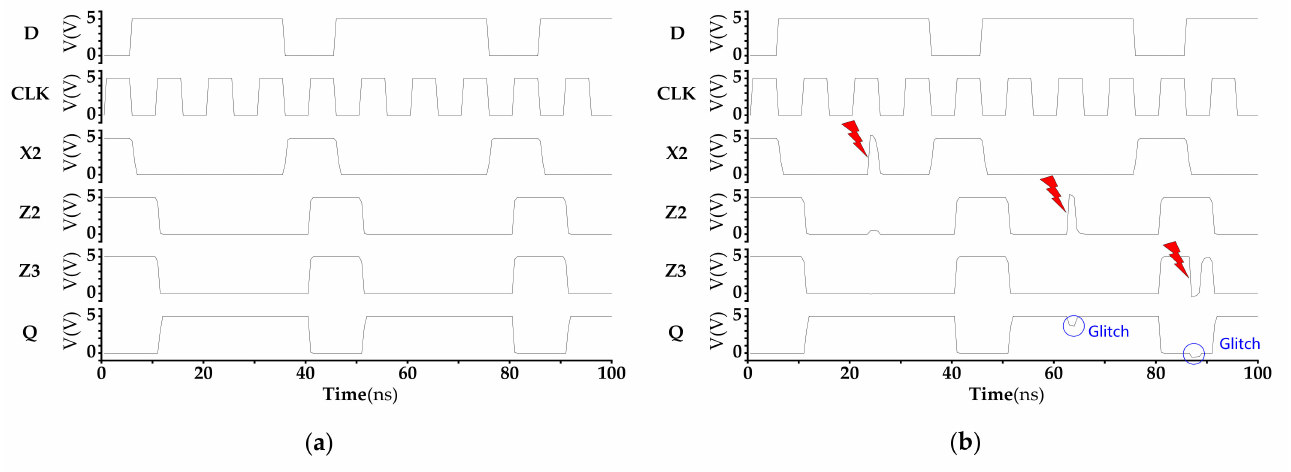
Figure 5. DICE-DICE: ( a ) simulation waveform of DICE-DICE without SETs; ( b ) simulation waveform of DICE-DICE with